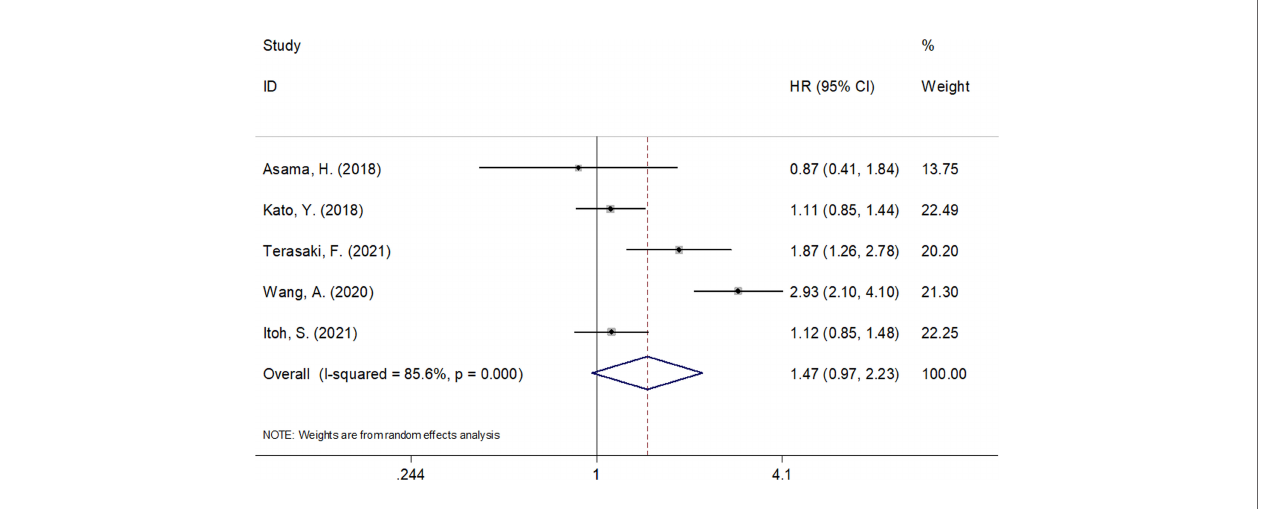
FIGURE 3 | Forest plots of CONUT score in predicting RFS in pancreatic cancer.